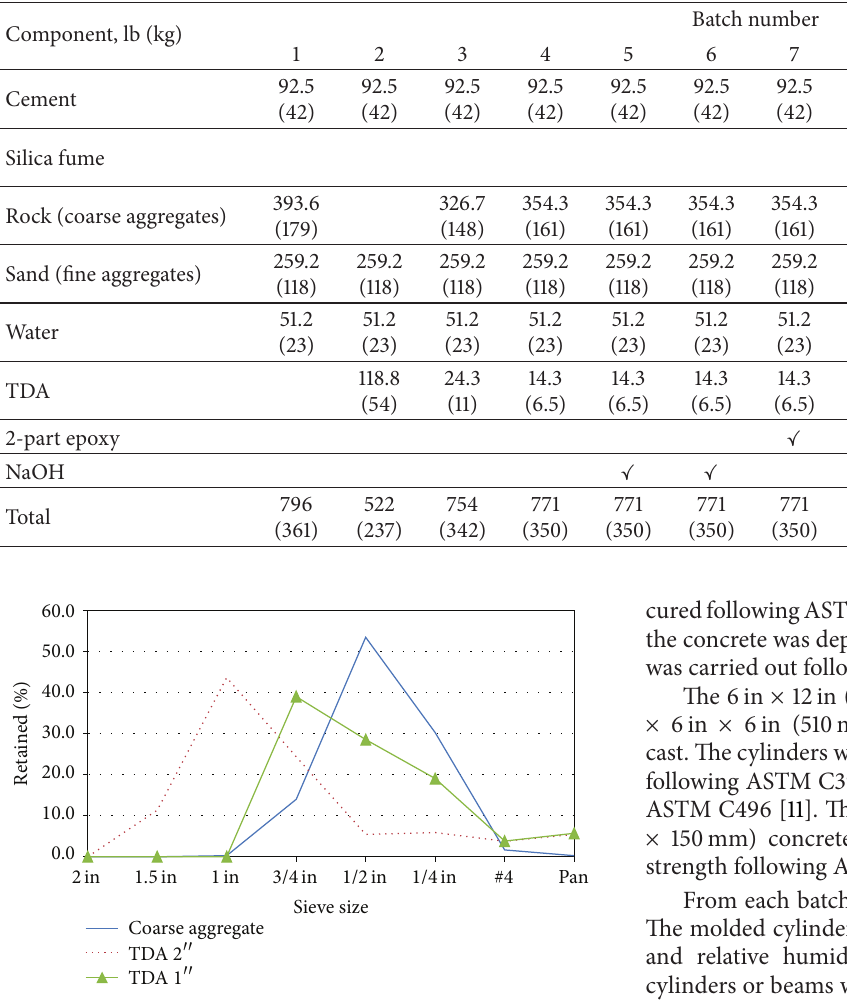
Figure 1: Coarse aggregate and TDA particle distribution compari-